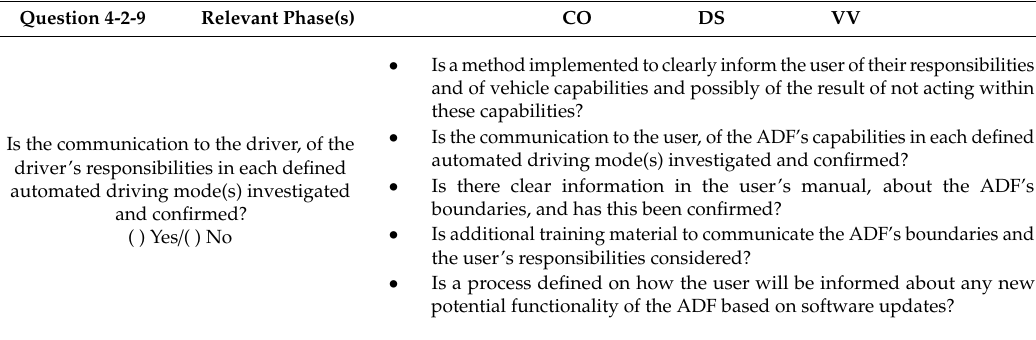
Table 5. Example question Mode Awareness, Trust, and